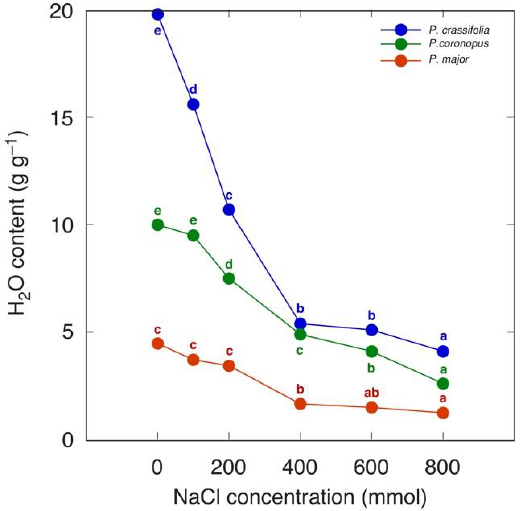
Figure 6. Effect of increasing salinity on leaf water content in three ecologically distinct Plantago species. Different letters of respective color indicate statistically significant differences ( p < 0.05) for the same species. Data were taken from Al Hassan et al., 2016 [185] and recalculated. In leaves of halophytic Lepidium latifolium plants, the water content increased by 46% at 300 mM NaCl, but it did not change in the glycophytic species Lepidium sativum (Table 5) [159]. Another halophytic species, Cochlearia officinalis , showed increased